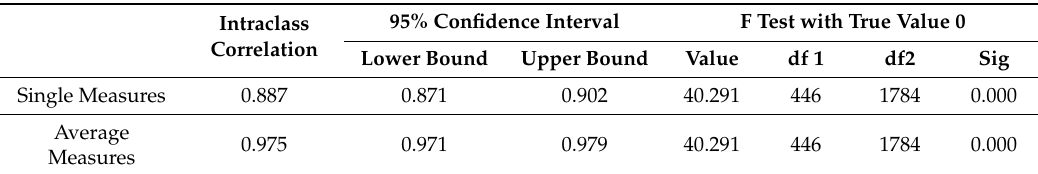
Table 2. Intraclass correlation coe ffi cient of experts’